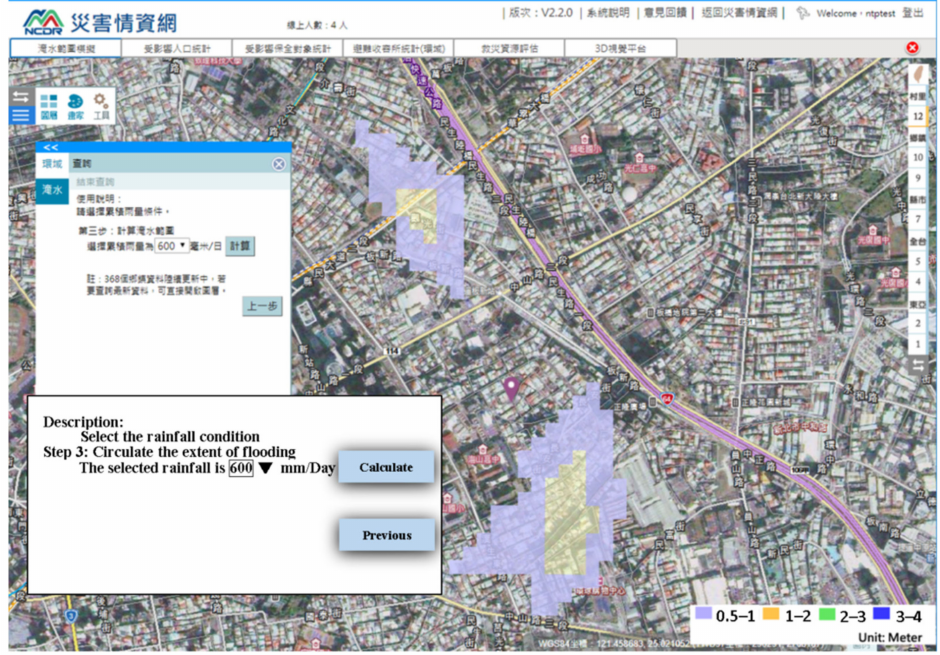
Figure 7. Method 3: Using a flooding potential map to calculate flooded areas. (2) Tab 2: Computation of the affected population.